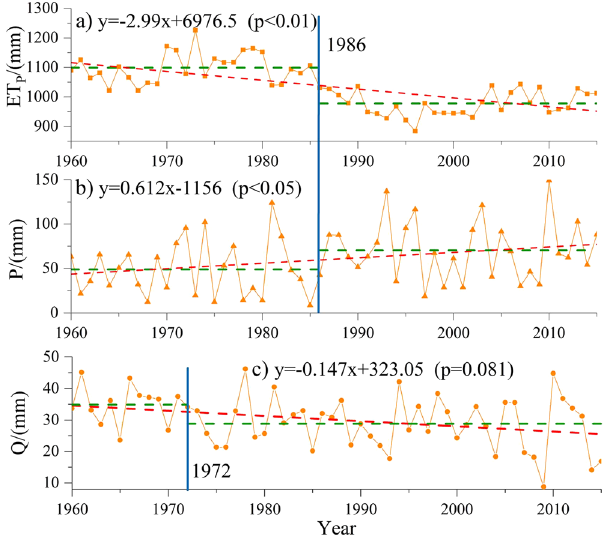
Figure 1. The trend of annual potential evapotranspiration, precipitation, streamflow at the Alar station in the Tarim River Basin during 1960~2015 (Note: P , ET P , Q indicate the precipitation, potential evapotranspiration and streamflow, respectively. Green dotted lines represent the average values during the prior impacted period and post impacted period, Red dotted lines represent annual variation tendency of the sequence. p value is the significance level of